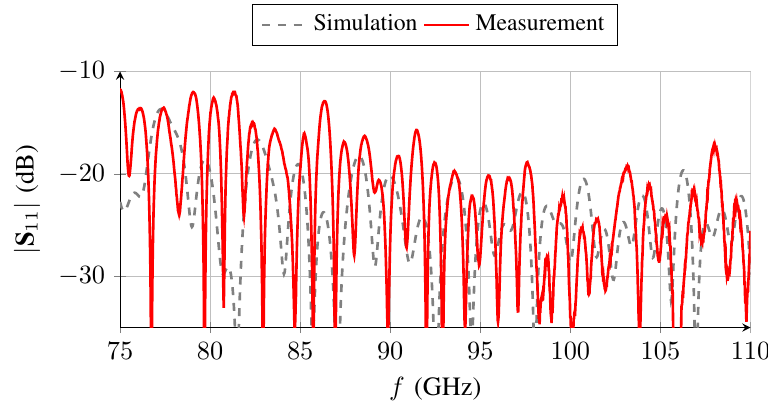
Figure 37. Simulated and measured input reflection of the antenna array.